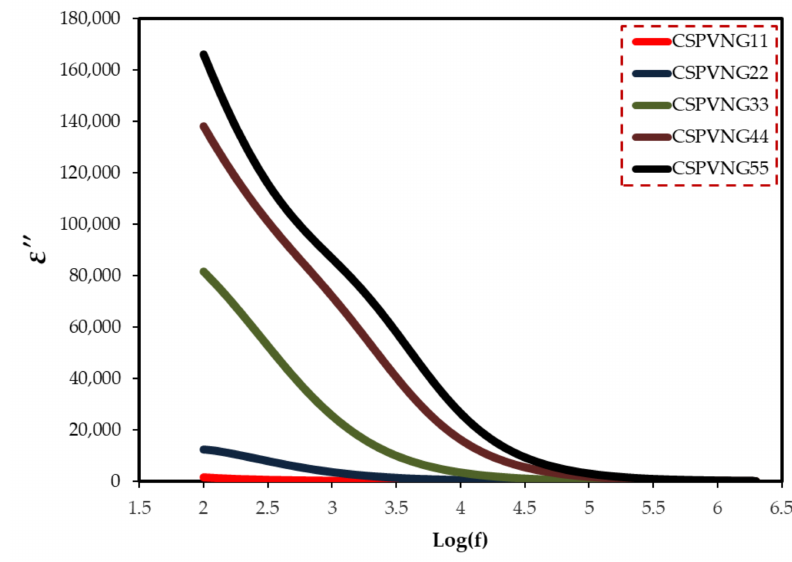
Figure 10. Dielectric loss versus log(f) for the electrolyte